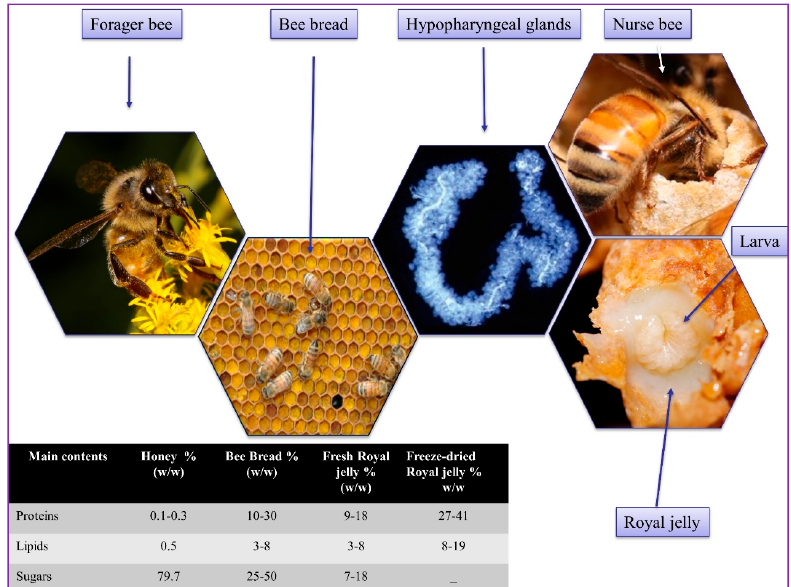
Figure 1. Forager bees transport pollens in their hind leg corbiculae to which they add nectar to form pollen pellets. Forager bees deposit and pack the pollen pellets into cell surrounding the brood area and forming bee bread. Nurse bees develop enlarged food glands and produce RJ by consuming honey and bee bread (Photos taken by Prof. Dr. Jianke Li).